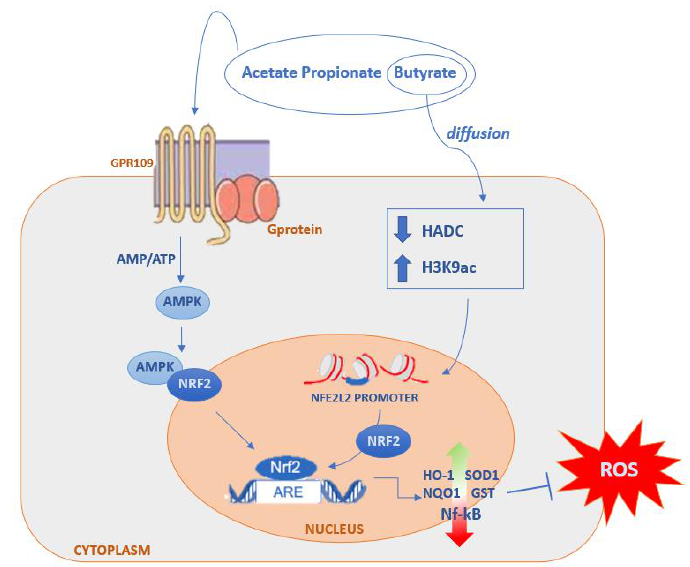
Figure 2. Direct and indirect mechanism of SCFAs on Nrf2 activation for modulation of oxidative stress. Binding of SCFAs to GPRC receptors induces direct activation of the nuclear factor Nrf2. Butyrate, on the other hand, also has a synergistic effect on Nrf2 activation because it diffuses into the cell lumen and, through HDAC inhibition, increases the production of histone H3K9ac, thus inducing an epigenetic modification on the Nrf2 promoter, indirectly activating Nrf2-dependent gene translocation and transcription. Abbreviations: AMPK, Activated Protein Kinase; HDAC, Histone Deacetylase; Nrf2, Nuclear Erythroid-Related Factor 2; ARE, Antioxidant Response element; HO-1, Heme Oxygenase-1; NQO1, NAD(P)H Quinone Dehydrogenase-1; NF- κ B, Nuclear Factor Kappa-light-chain-enhancer of Activated B cells; SOD1, Superoxide Dismutase 1; GST, Glutathione S-transferase.